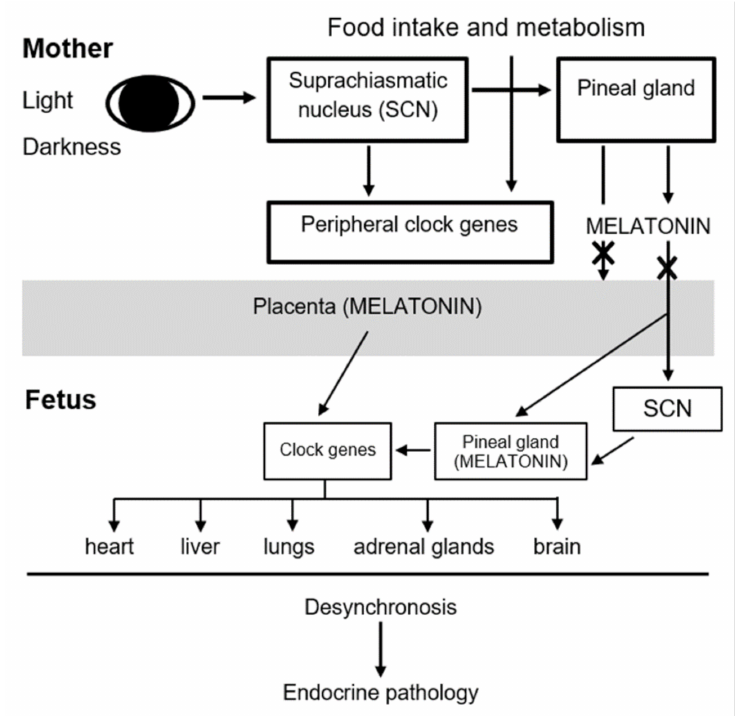
Figure 1. Maternal melatonin deficiency leads to endocrine pathologies in